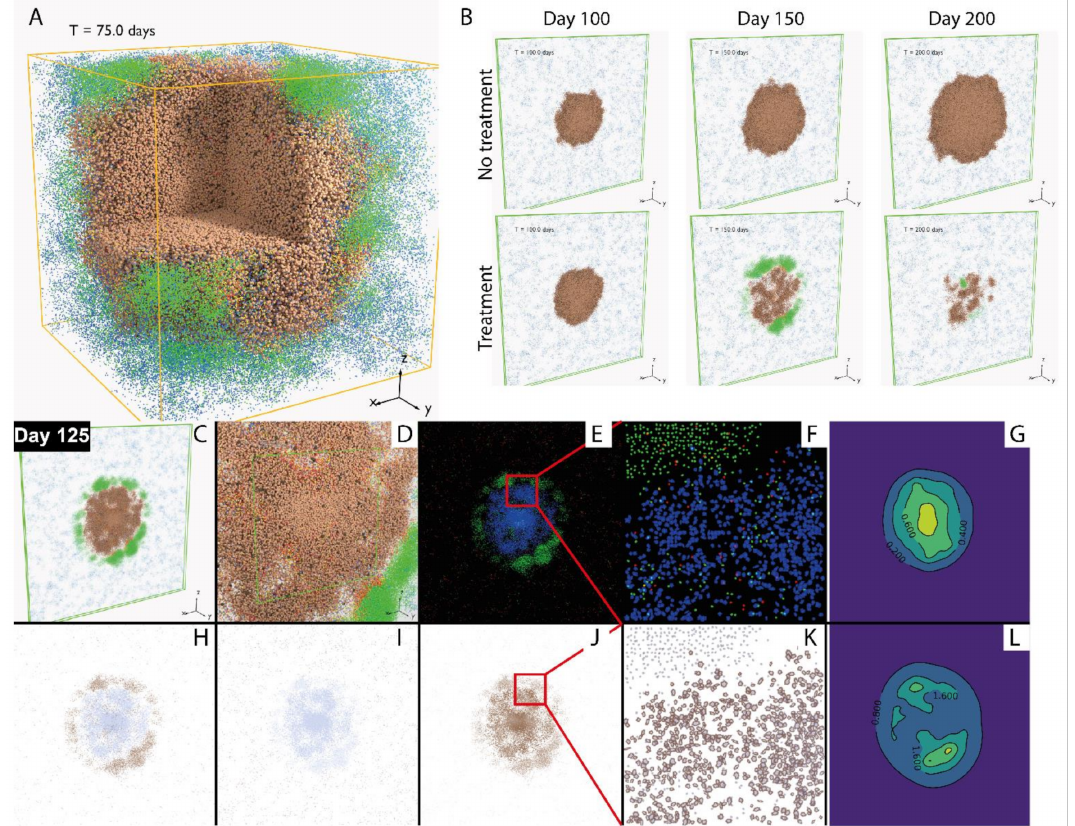
Figure 4. Visualization of spatio-temporal tumor dynamics. ( A ) Simulated tumor in 3 × 3 × 3 mm volume. Cancer cells: brown: progenitor cells; red: cancer stem cells (CSC); grey: senescent cells; T cells: blue: Tregs; green, red, and yellow: CD8+ T cell, as newly recruited, enhanced, and exhausted states. ( B ) Simulated tumor in 10 × 10 × 0.2 mm volume, with or without anti-PD-1 treatment. ( C – L ) Snapshots of tumor at day 125 after treatment began. ( C ) 3D visualization. ( D ) Close-Up 3D visualization of cells. ( E ) Virtual multiplex immunofluorescence (mIF) (red: Treg; blue: cancer cells; green: Teff). ( F ) Close-Up virtual mIF. ( G ) Simulated IL-2 concentration distribution, ng/mL. ( H ) Virtual immunohistochemistry (IHC), CD8+. ( I ) Virtual IHC, FoxP3+. ( J ) Virtual IHC, PD-L1+. ( K ) Close-Up of J. ( L ) Simulated IFN γ concentration distribution,